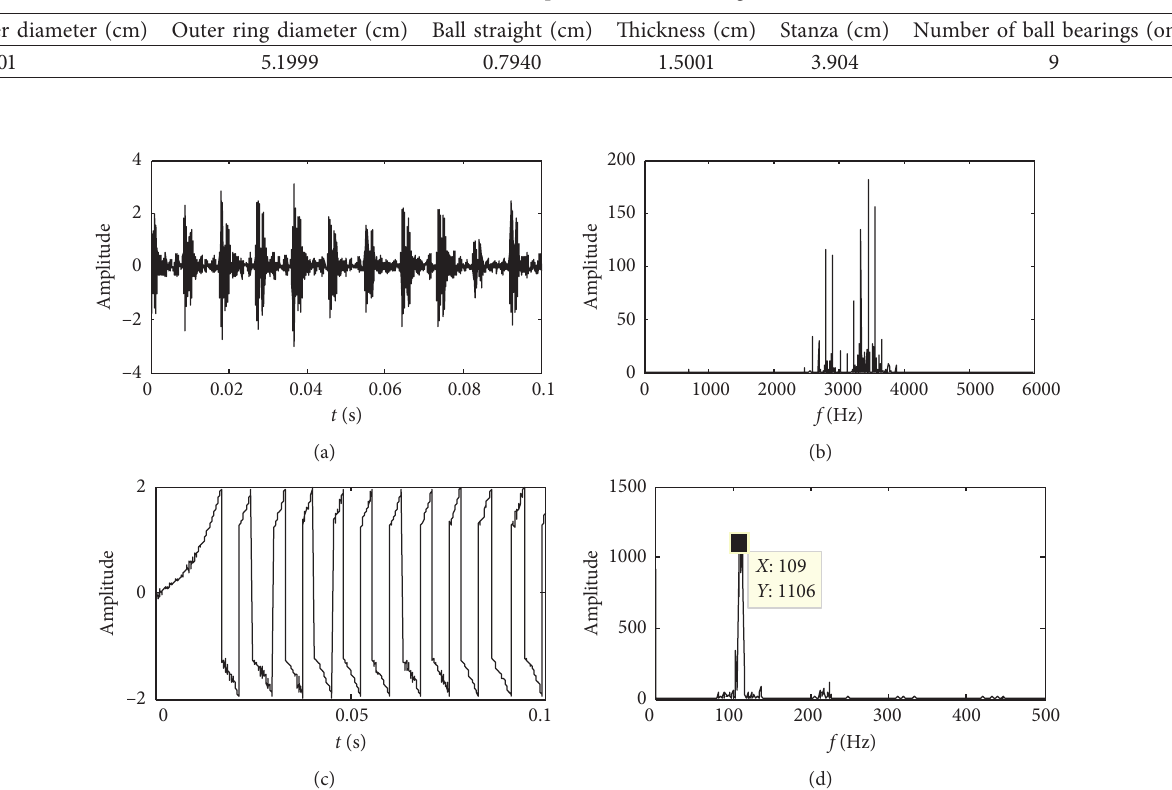
Figure 8: Time and frequency-domain diagrams of input and output of outer circle fault detection system ( a � 0 . 422000206845763 ,b � 0 . 01 ,c � 2 . 645191139445148 ,r � 1 )